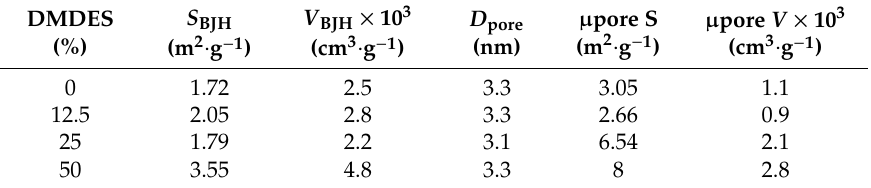
Table 3. Textural properties of G5 hybrid films at different DMDES loadings.